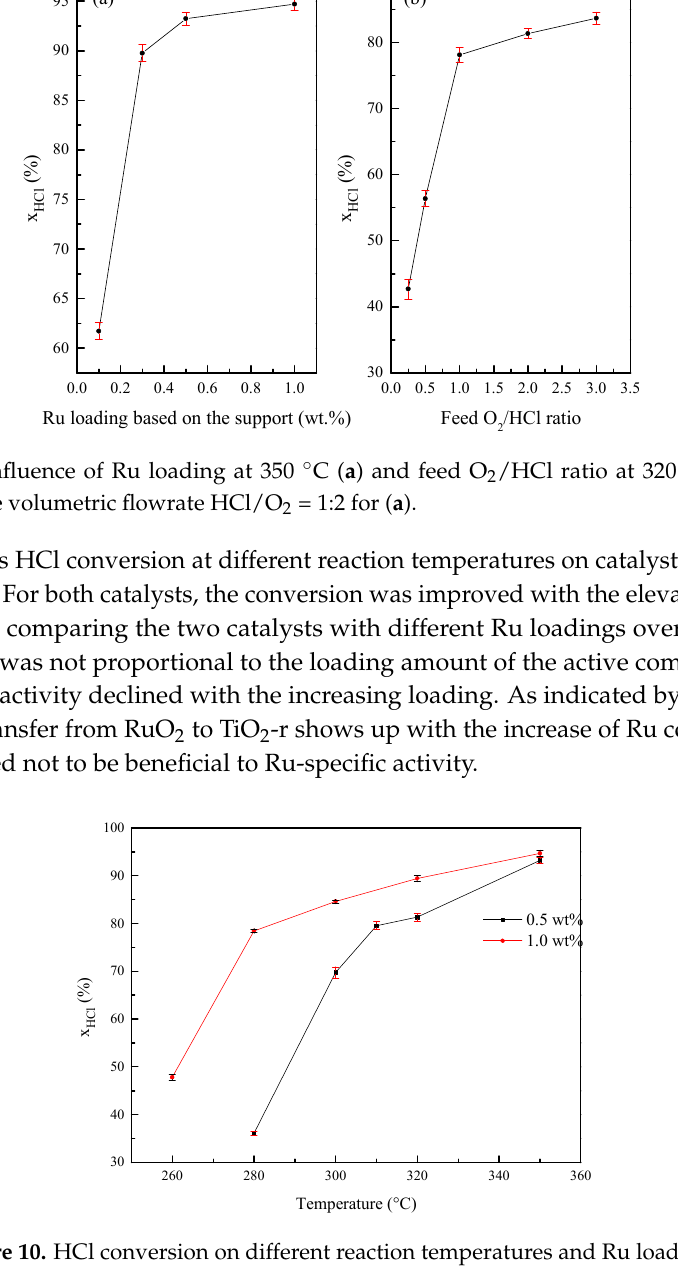
Figure 10. HCl conversion on different reaction temperatures and Ru loading.